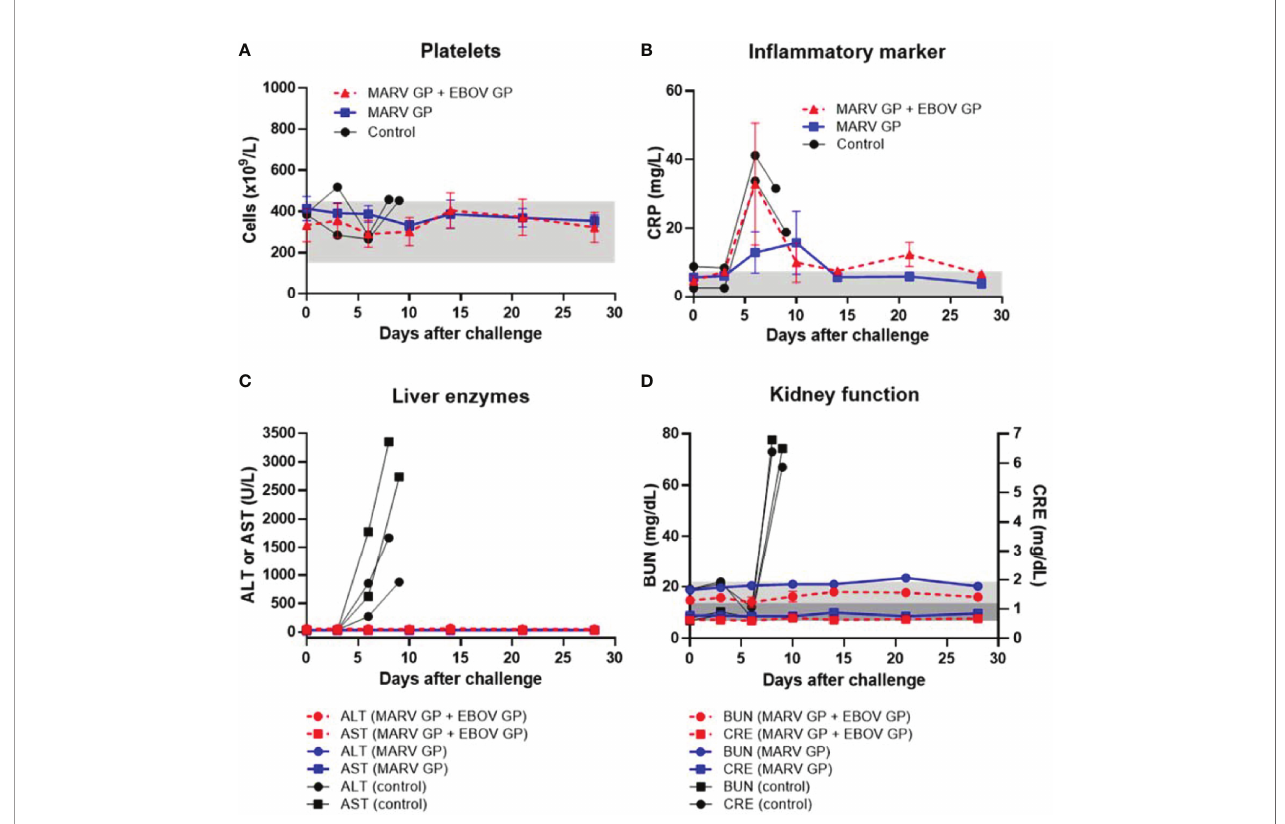
FIGURE 7 | Platelet counts, in fl ammatory marker,liver enzymes, andkidney function after MARV challenge. (A) Platelet counts with normal range of150-450 x 10 3 cells/ m L shownas light grey band. (B) Serum CRP with normal range of 0.0-7.5 mg/L shownas light grey band. (C) Serum ALTwith normal range of10-47 U/L and serum AST with normalrange of 11-38 U/L. (D) Serum BUNwith normalrange of 7-22 mg/dL shownas light grey bandand CRE with normal range of 0.6-1.2 mg/dL shown as darker grey band. Each data point for vaccinated groups represents mean ± SEM. Data points for controls were plotted per individual